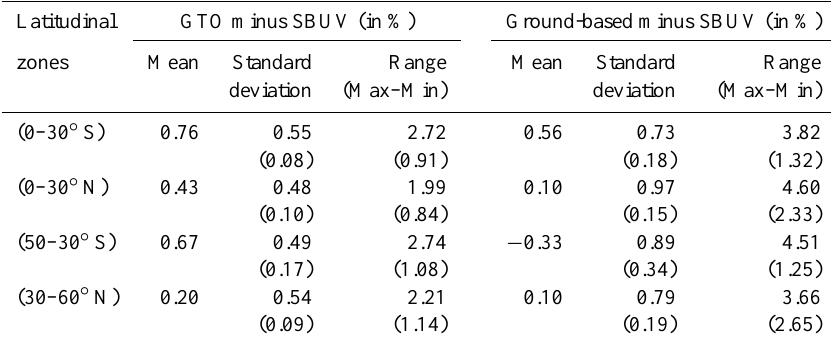
Table 6. Summary of the differences in seasonal zonal mean total ozone (four broad latitudinal zones).